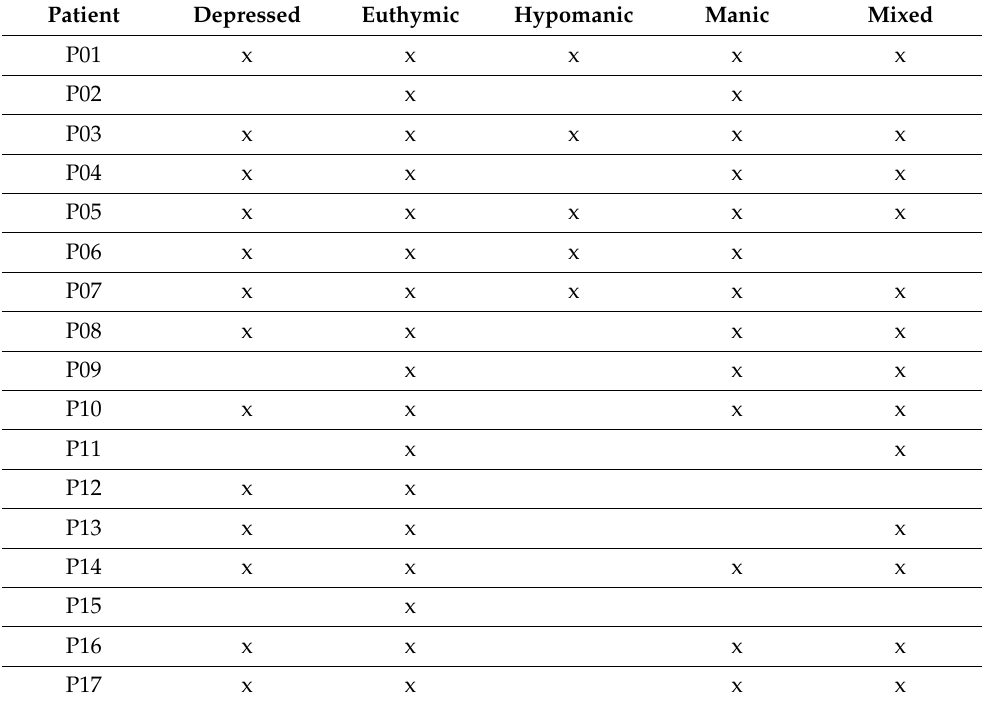
Table 2. States of the patients during the recollection period.